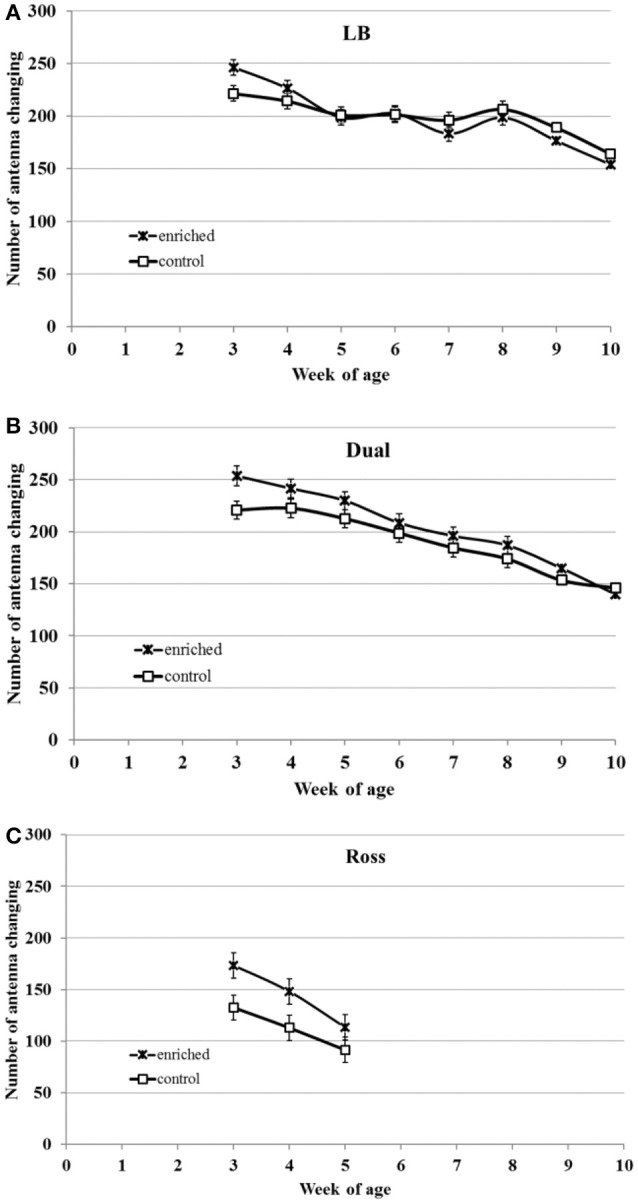
Locomotor activity (LSM ± SEM) of chickens from three strains [(A) LB, (B) Dual, and (C) Ross] with (enriched) and without (control) elevated structures. The locomotor activity was measured in means of the number of changes between two floor antennas.